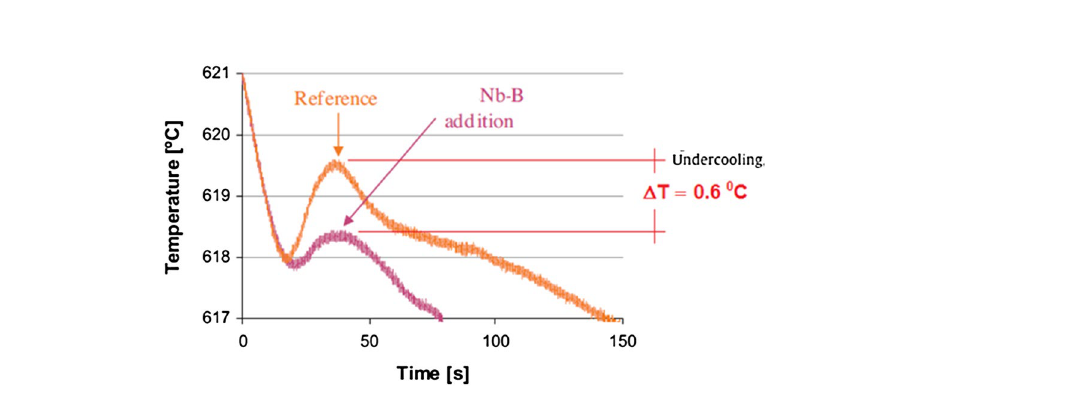
Figure 4. Variation in grain size versus solidification time of Al-Si alloys without (reference) and with inoculation (Nb + B). Adapted from Ref. 10 .